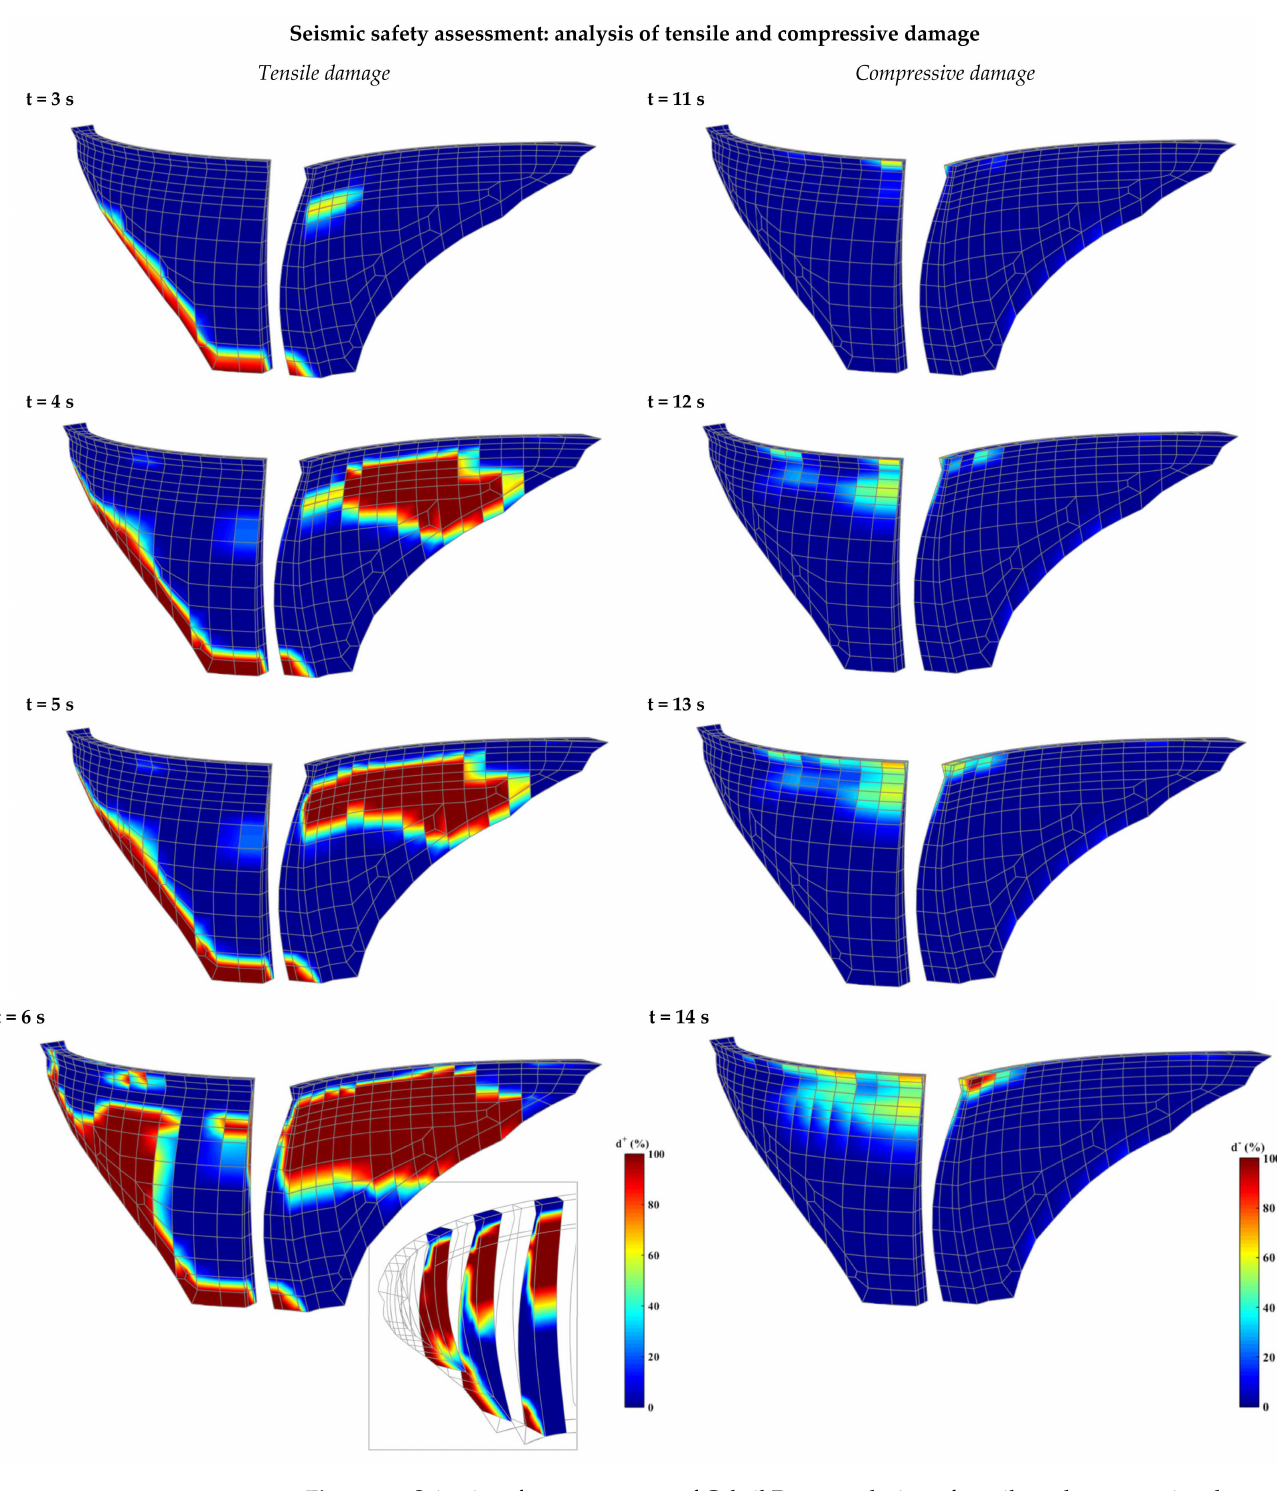
Figure 10. Seismic safety assessment of Cabril Dam: evolution of tensile and compressive damage for increasing acceleration